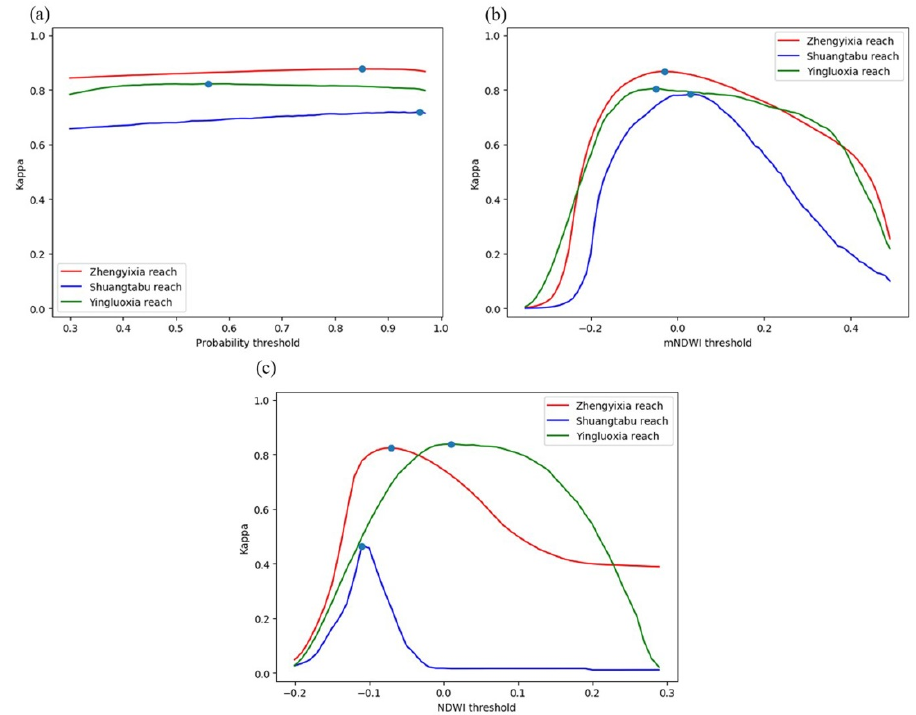
Figure 9. The Kappa coefficient values when using different thresholding values for ( a ) posterior probability images, ( b ) mNDWI images, and ( c ) NDWI images at three river reaches. Optimal threshold values were highlighted with dots on each line.